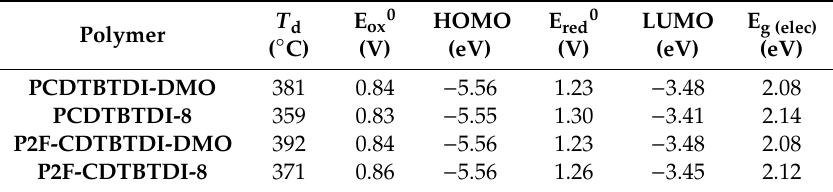
Table 3. Thermal and electrochemical properties of the